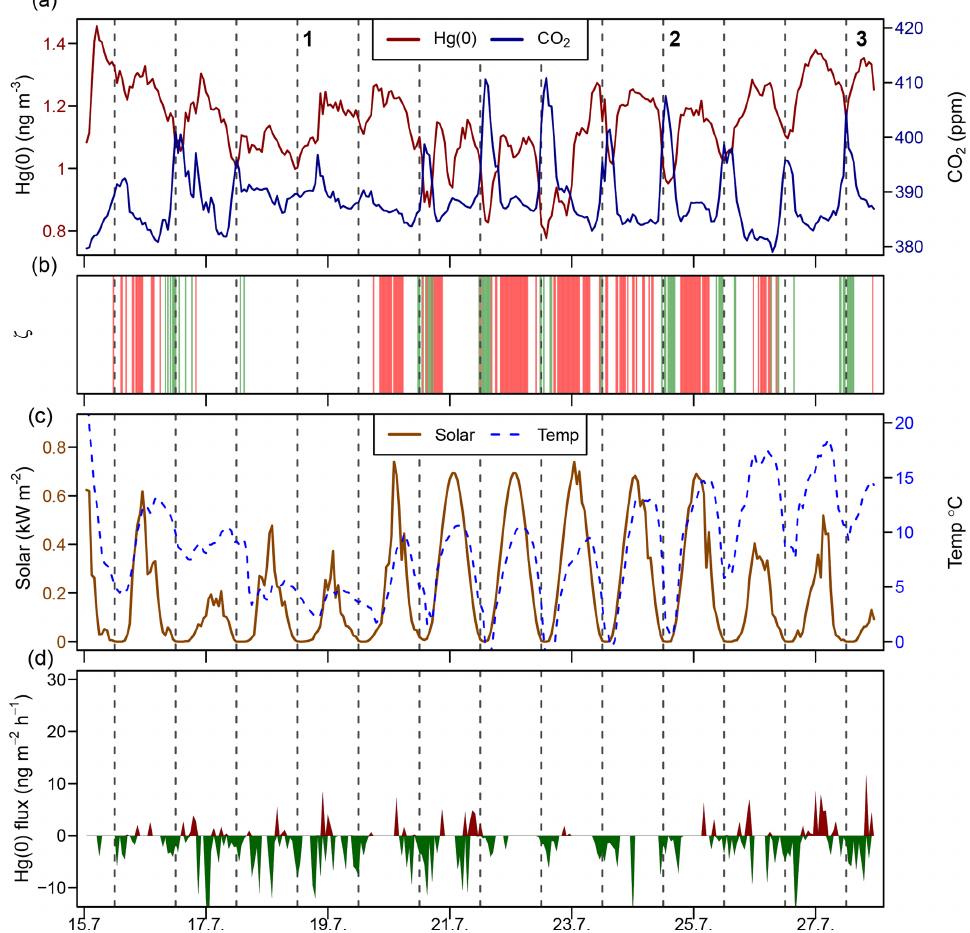
Figure 5. Time series during a midsummer period (15–28 July 2016) of the (a) atmospheric Hg(0) concentration and CO 2 mixing ratio; (b) median planetary boundary layer stability ( ζ ), where the shaded areas in green represents stable conditions ( ζ > 0 . 1) and shaded areas in red represent turbulent conditions ( ζ < − 0 . 1); (c) solar radiation and air temperature; and (d) Hg(0) flux, with Hg(0) deposition in green and Hg(0) re-emission in red. Midnight is indicated by dashed